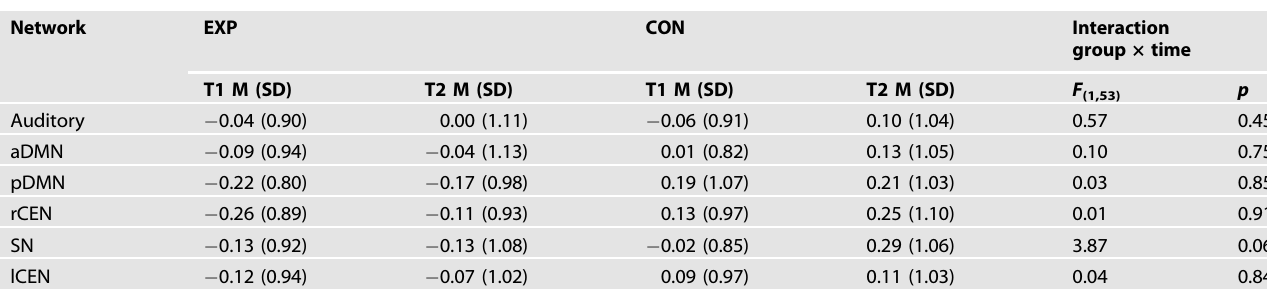
Table 5. ANOVA for intergrity of FDG-PET-based